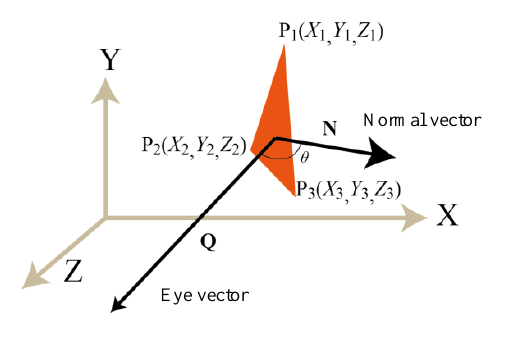
Figure 11. Relationship between eye vector and normal vector.